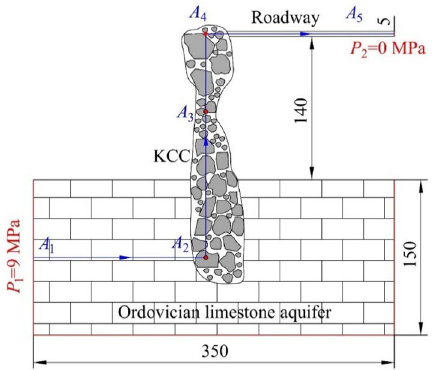
Figure 6. Numerical model of the of the Karst collapse column.